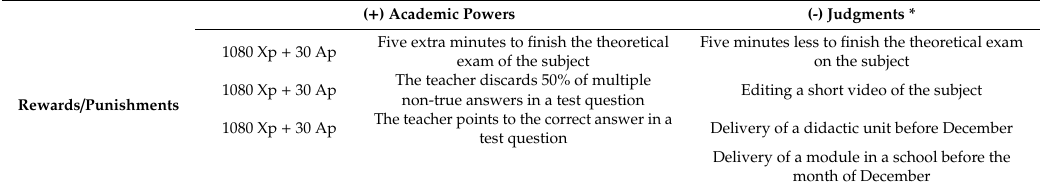
Table 4. Equivalences for rewards and punishments and gamified